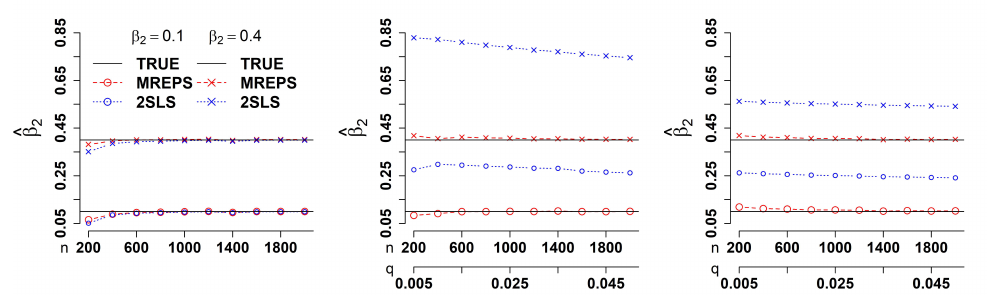
Figure 2. ( Left ): the behavior of the estimators due to the change of sample size, obtained through MREPS and 2SLS under the random design. ( Middle and right ): the behavior of the estimators, due to the change of sample size or the proportion of the extreme tails, obtained through MREPS and 2SLS under the EPS Y and EPS X ,